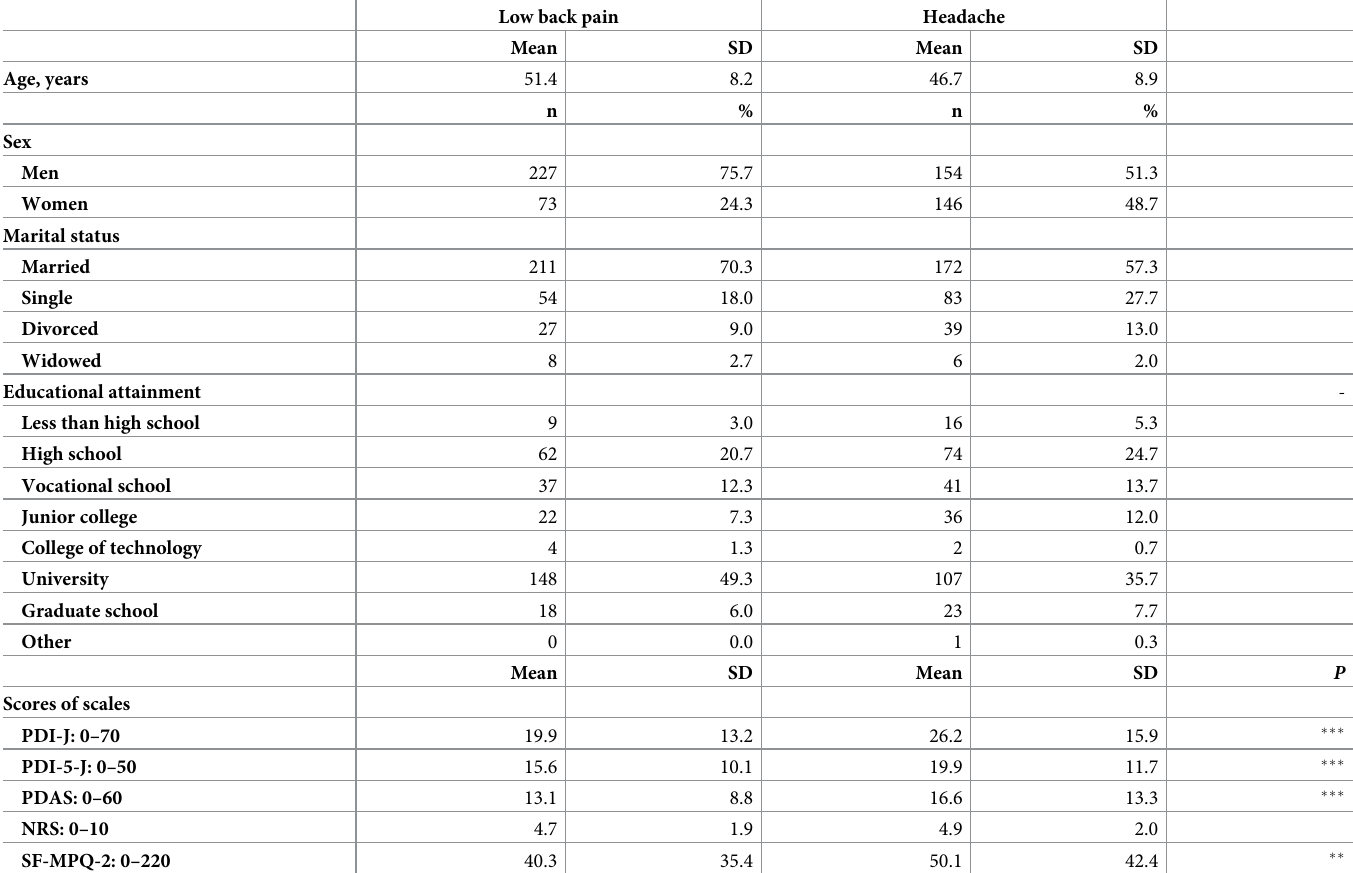
Table 1. Mean and proportion of characteristics (n =